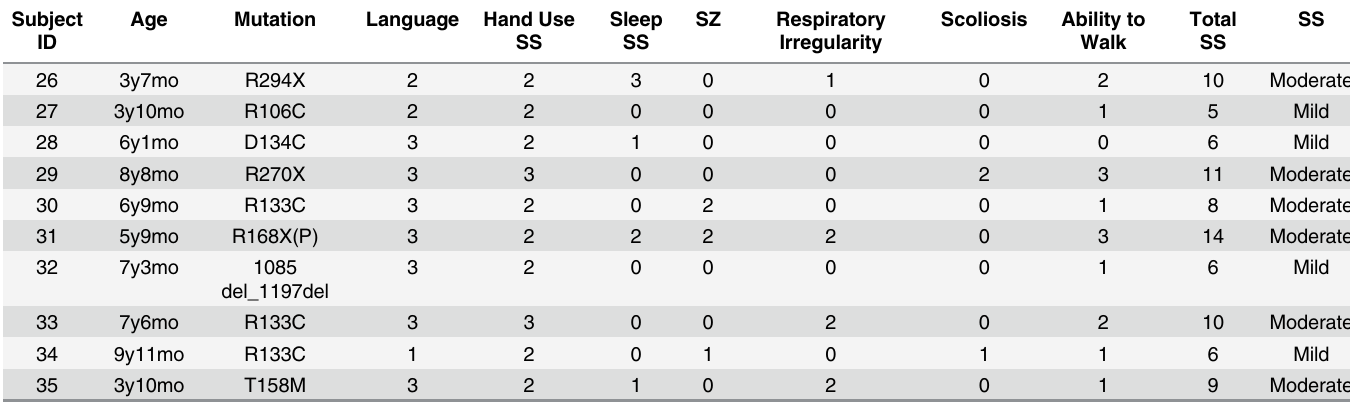
Table 2. Clinical severity scores.